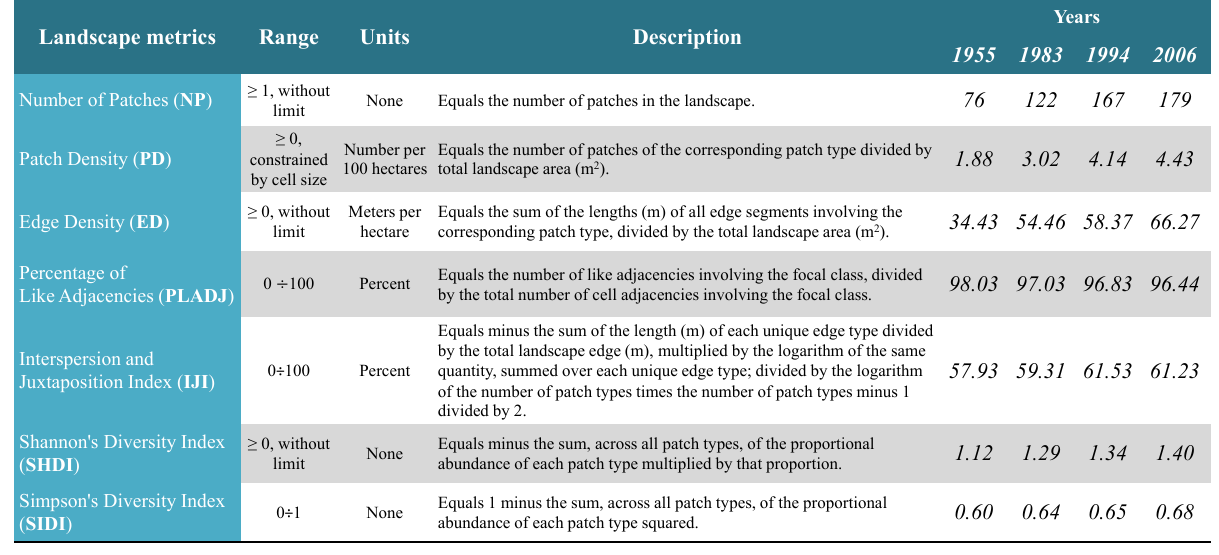
Fig. 6. Description of landscape metrics (based on McGarigal et al., 2012) and their values obtained at landscape level for all time intervals under investigation.